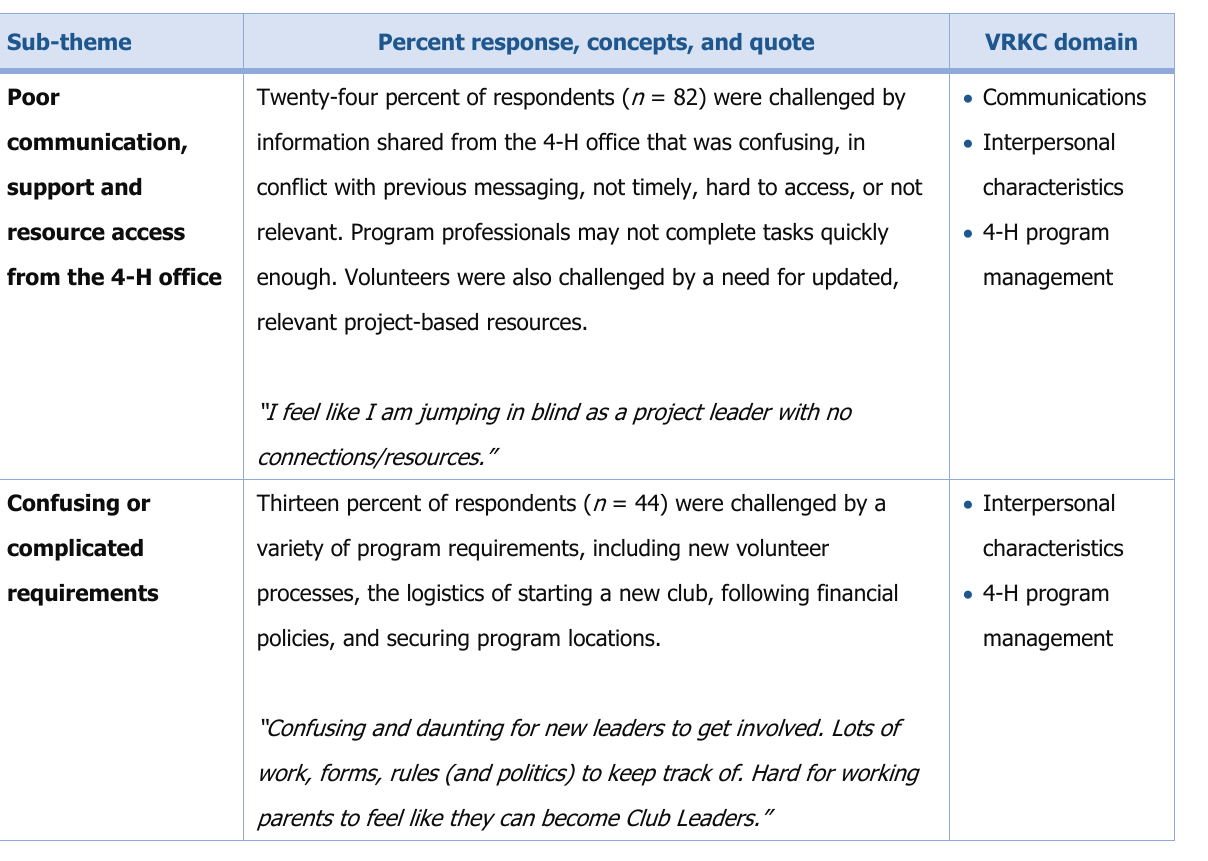
Table 8. “Challenges” Sub -Themes of the Program Administration and Communication Theme